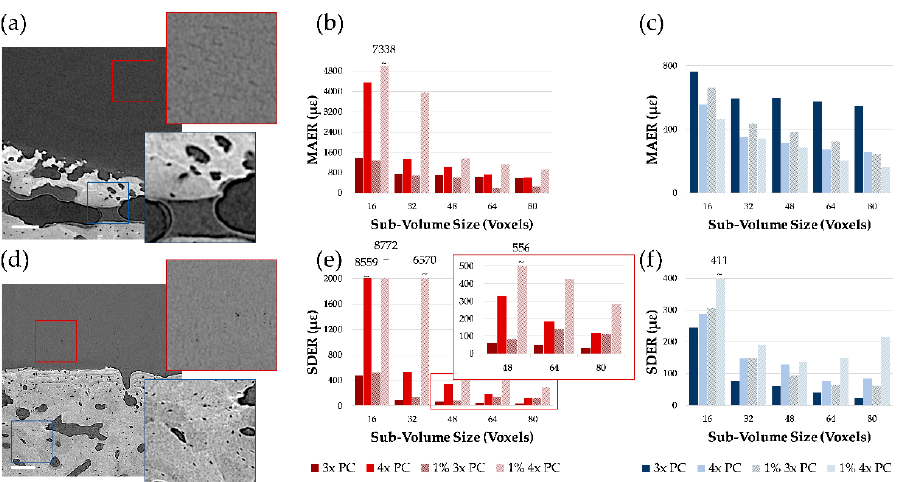
Figure 4. Strain uncertainty analysis for the contrast ‐ enhanced specimens. XCT cross ‐ sections of ( a ) CB1 and ( d ) CB5 samples imaged in propagation ‐ based (3× and 4×) phase ‐ contrast (PC) showing clear features in the articular cartilage region. Scale bars are 200 µm. ( b , c ) Mean absolute error (MAER) and ( e , f ) standard deviation of the error (SDER) are shown for ( b , e ) the articular cartilage and ( c , f ) the mineralized regions of the specimens for the zero ‐ strain and 1% synthetic deformation tests at varying sub ‐ volume sizes.